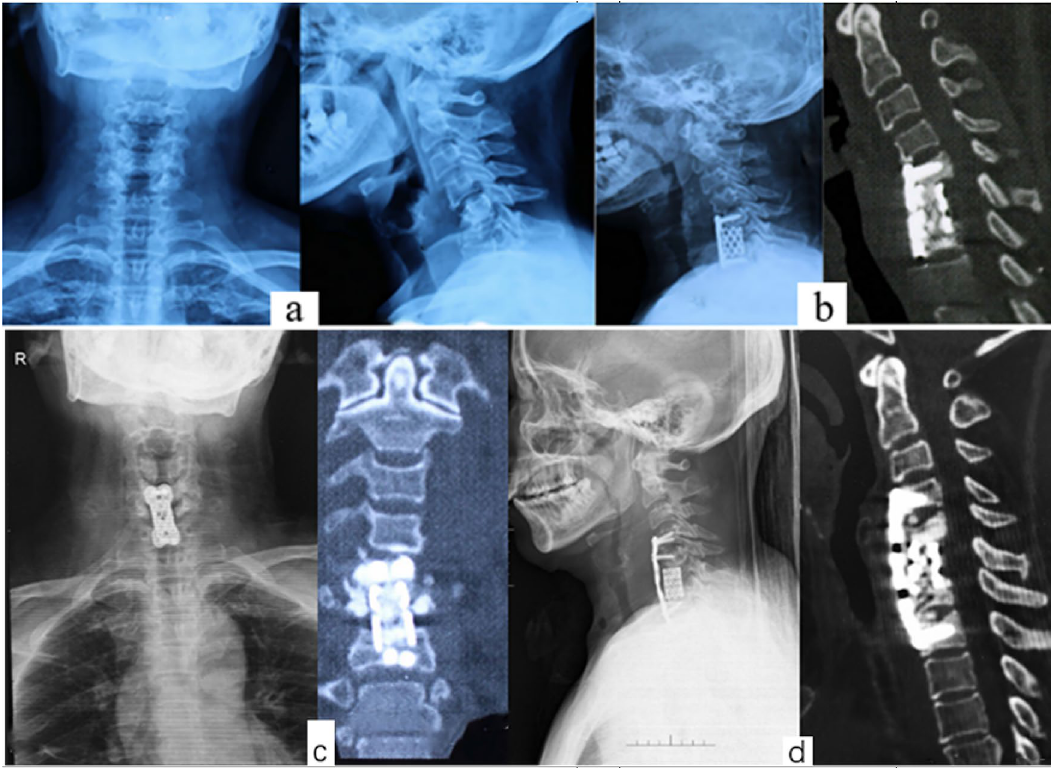
Figure 2. A 61 years old female with cervical TB at C5–7 and refractory kyphosis who didn’t undergo preoperative traction, ( a ) preoperative AP and lateral X-rays, no dynamic X-ray films because the patient was unable to flex or extend the neck. ( b ) Postoperative X-ray and CT, the disease lesion was cleared but the kyphosis was still there. ( c ) AP X-rays and CT-scan showing subsidence of titanium mesh, thus second operation